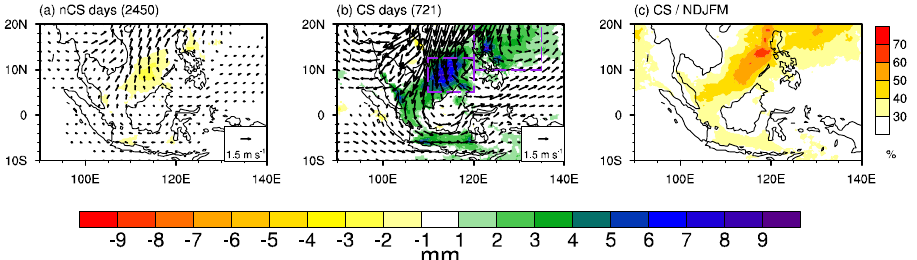
Figure 2. Composite anomalies of precipitation [shade, shade interval (SI) = 1 mm] and 925 hPa winds (vector, unit: 1.5 ms − 1 ) during ( a ) no cold surge days and ( b ) cold surge days, respectively. ( c ) is the ratio (shade, SI = 10%) of total precipitation in ( b ) to that for all winter days. Number in left title indicates the composite days. Rectangles in ( b ) represent the regions over the EPH (10°–20°N, 120°–135°E) and NBO (5°–12.5°N, 110°–120°E), respectively. Values and vectors exceeding the 95% confidence levels based on the two-tailed Student’s t -test are shown in ( a , b ).